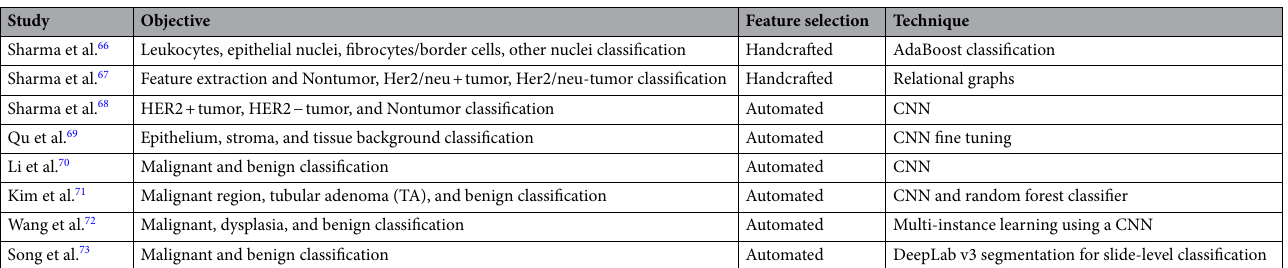
Table 10. Methods and results for computer-aided analyses of whole-slide stomach